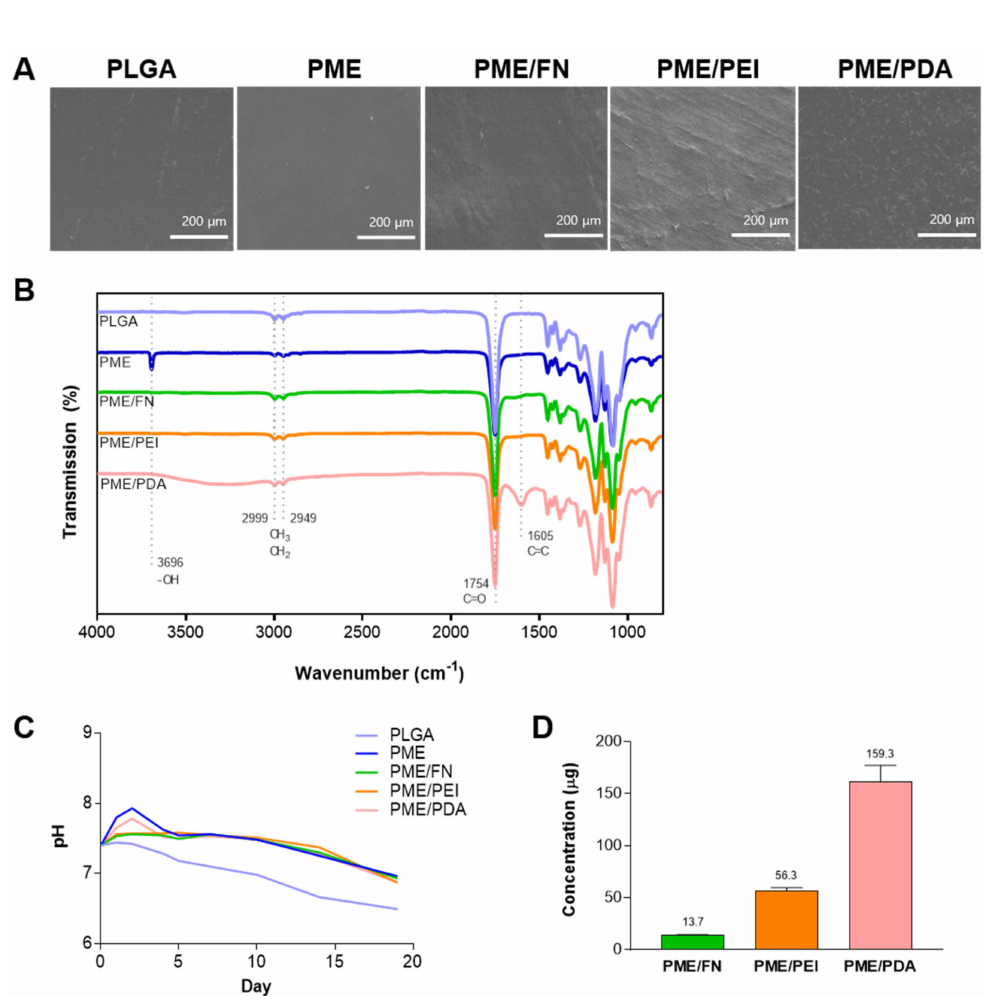
Figure 1. Characterization of surface-modified composite films. ( A ) Representative SEM images of the PLGA composite films. ( B ) ATR-FTIR spectra. ( C ) The changes in pH. ( D ) The total amount of coating materials on the surface of composites. Scale bars = 200 µ m. The data are expressed as mean ± SD ( n =